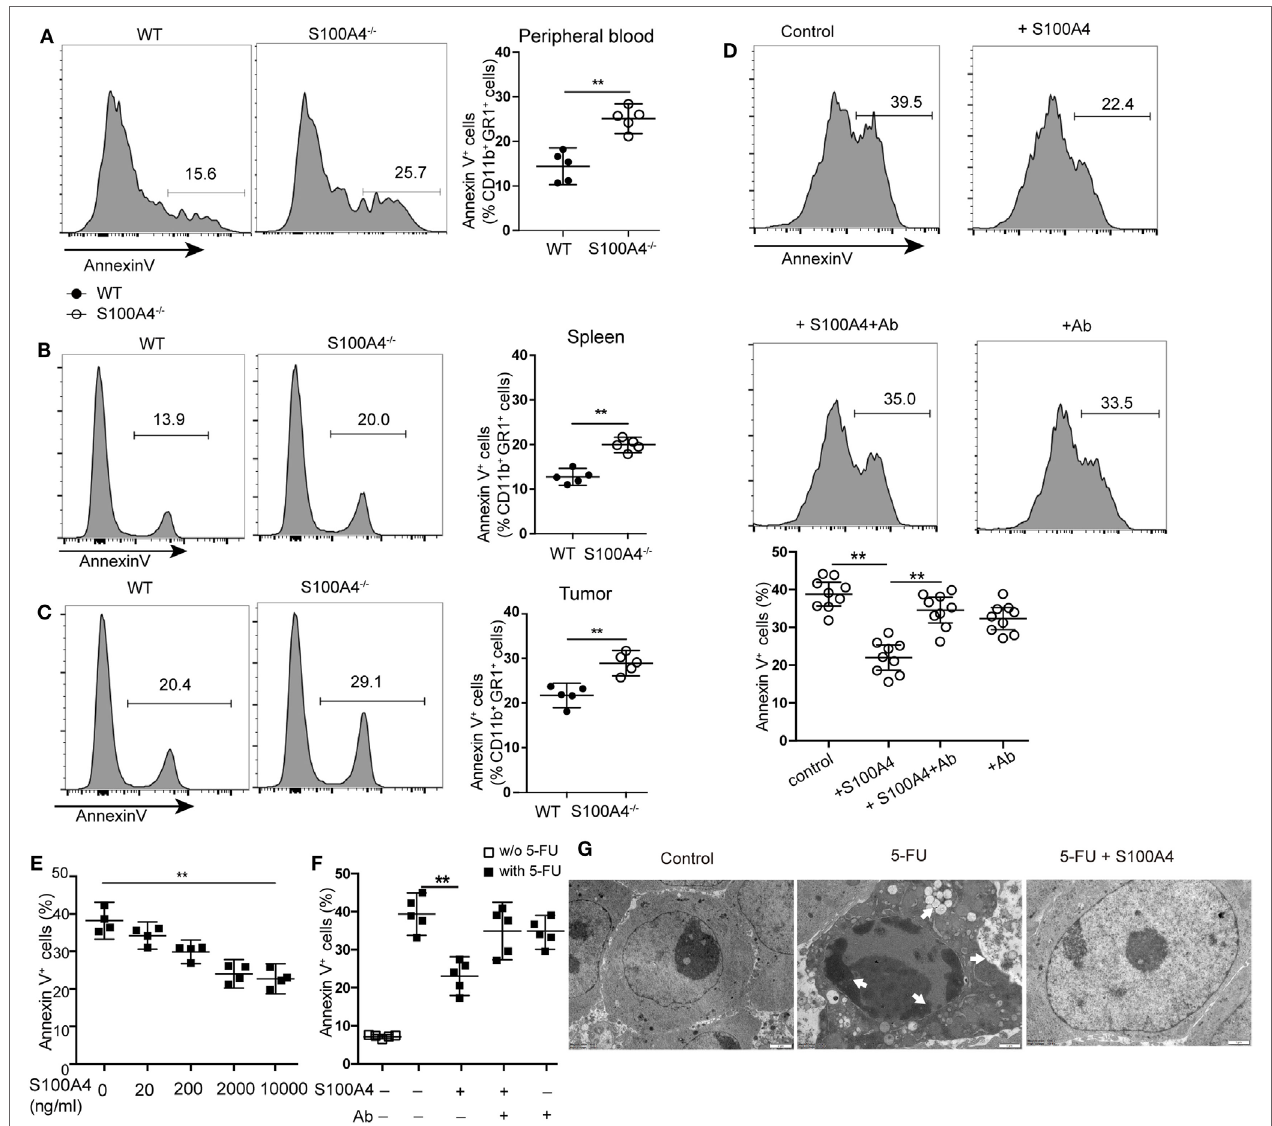
FigUre 3 | Extracellular S100A4 protecting myeloid-derived suppressor cells (MDSCs) from apoptosis. (a) Peripheral blood cells, (B) splenocytes, or (c) tumor cells were isolated from wild type (WT) and S100A4 − / − mice and stained for CD11b, GR1, and exposed phosphatidylserine. The proportion of Annexin V + cells within the CD11b + GR1 + population was detected by flow cytometry. (a–c) Representative results of three independent experiments are shown. Mean and 95% CI, n = 5 mice per group; ** P < 0.01, Mann–Whitney. (D) MDSCs isolated from S100A4 − / − mice were cultured for 24 h in the presence of recombinant S100A4 (1 µg/mL) alone or with S100A4 preincubated with the 3B11 antibody (6 µg/mL). The proportion of Annexin V + cells within the CD11b + GR1 + population was detected by flow cytometry. Combined raw data from three independent experiments are shown. Mean and 95% CI, n = 9 per group; ** P < 0.01, Mann–Whitney. (e) MSC2 cells were pretreated with 100 ng/mL of IL-4 for 2 days. MSC2 cell apoptosis induced by 5-fluorouracil (5-FU) alone or in the presence of increasing concentrations of S100A4 was assessed by Annexin V-binding. Representative results of three independent experiments are shown. Mean and 95% CI, n = 4 per group; ** P < 0.01, Mann–Whitney. (F) MSC2 cells were treated for 24 h with 5-FU alone or in the presence of recombinant S100A4 (1 µg/mL) and the neutralizing antibody 3B11 (6 µg/ mL). Annexin V-binding was evaluated by flow cytometry. Representative results of three independent experiments are shown. Mean and 95% CI, n = 5 per group; ** P < 0.01, Mann–Whitney. (g) MSC2 cell morphology was studied by transmission electron microscopy. Cells were left untreated (control) or were incubated with 5-FU alone or in combination with S100A4 for 24 h. Arrows point to karyopyknosis, to undulations in the plasma membrane, and to vacuoles. Representative results of three independent experiments are shown; n = 4 per group. Scale bars: 1